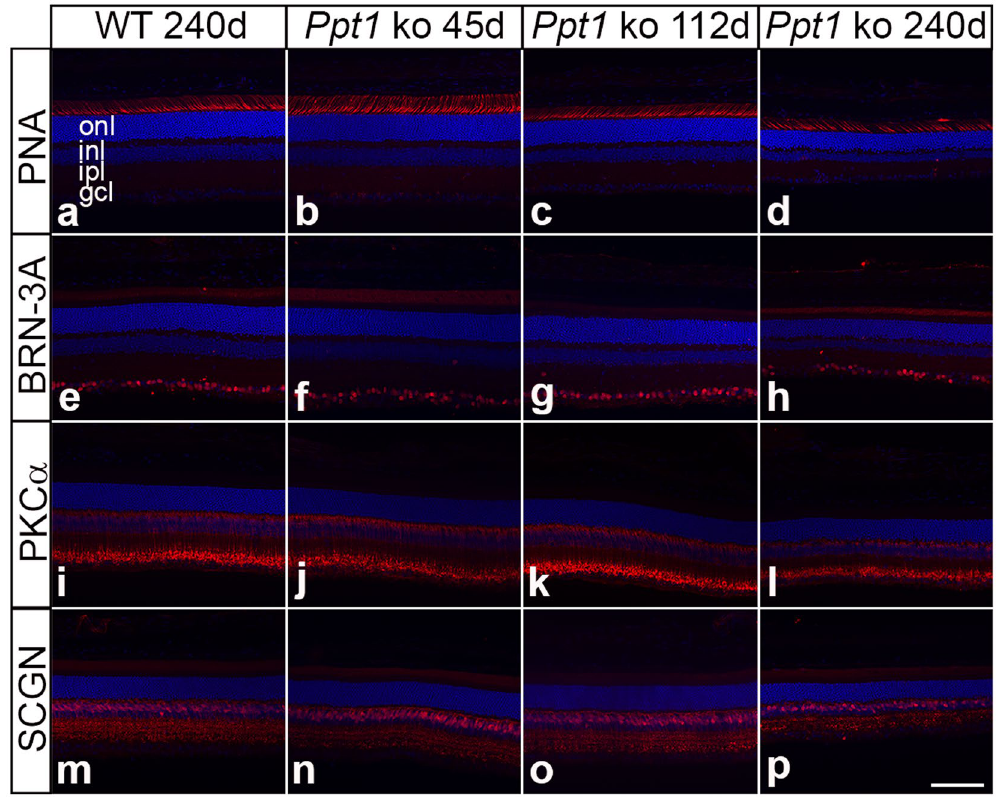
Figure 8. Degeneration of various retinal cell types in PPT1-deficient mice. The density of PNA-labelled cone photoreceptor cells, BRN-3A-positive retinal ganglion cells, PKC α -positive rod bipolar cells and SCGN-positive cone bipolar cells in 45-day-old Ppt1 ko retinas ( b,f,j,n , respectively) was similar to that observed in wild-type retinas ( a,e,i,m , respectively). Retinas from 112-day-old Ppt1 ko mice also contained normal numbers of retinal ganglion cells ( g ) and rod bipolar cells ( k ), but decreased densities of cone photoreceptor cells ( c ) and cone bipolar cells ( o ). Note the significant decrease in the number of all cell types in 240-day-old mutant retinas ( d,h,l,p ) when compared to age-matched wild-type retinas (a,e,i,m). gcl: ganglion cell layer; inl: inner nuclear layer; ipl: inner plexiform layer; onl: outer nuclear layer. Scale bar in ( p ) for ( a–p ): 100 µ